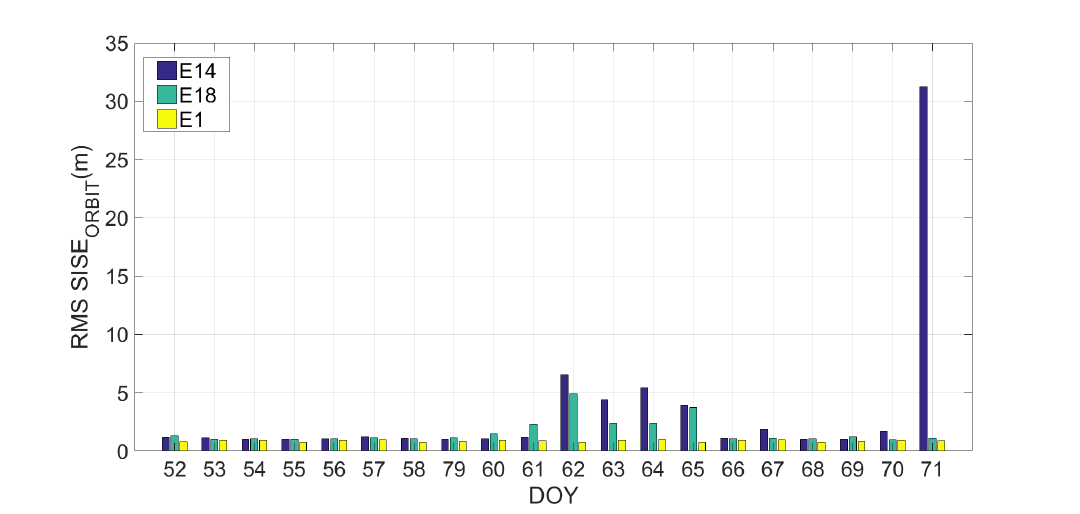
Figure 6. Daily RMS SISE orbit calculated on the dataset ranging from DOY 52 to 71 for satellite 1 (E1), Milena (E14) and Doresa (E18) satellites reported in yellow, blue and green, respectively.